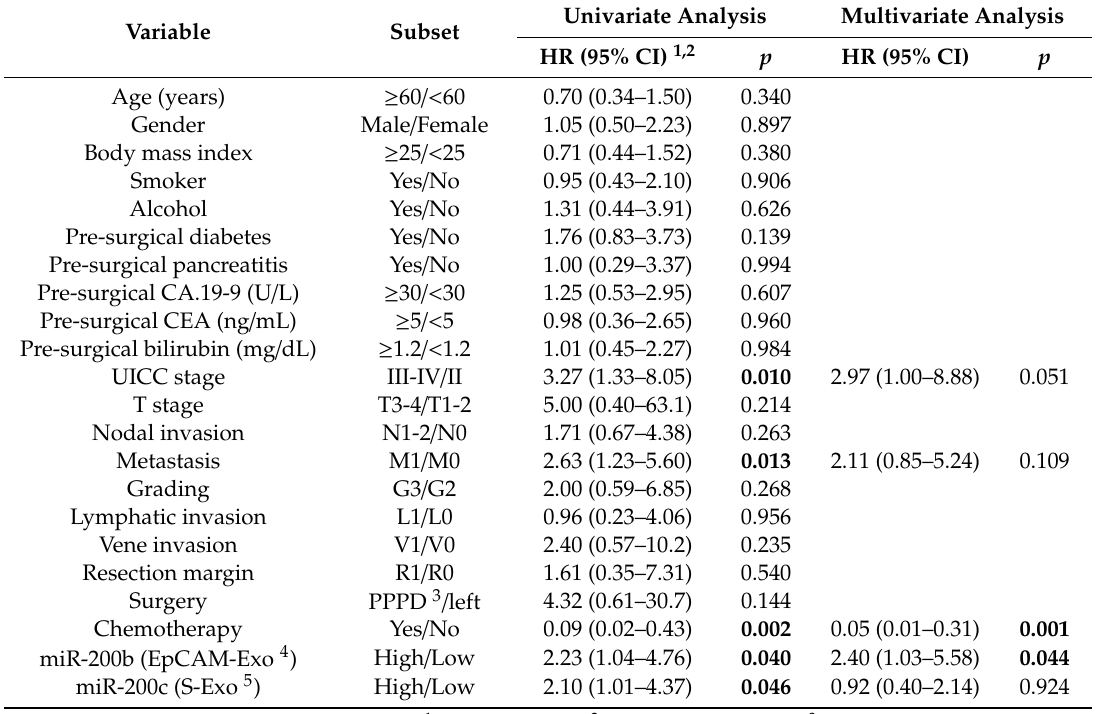
Table 3. Univariate and multivariate survival analysis for overall survival of PDAC